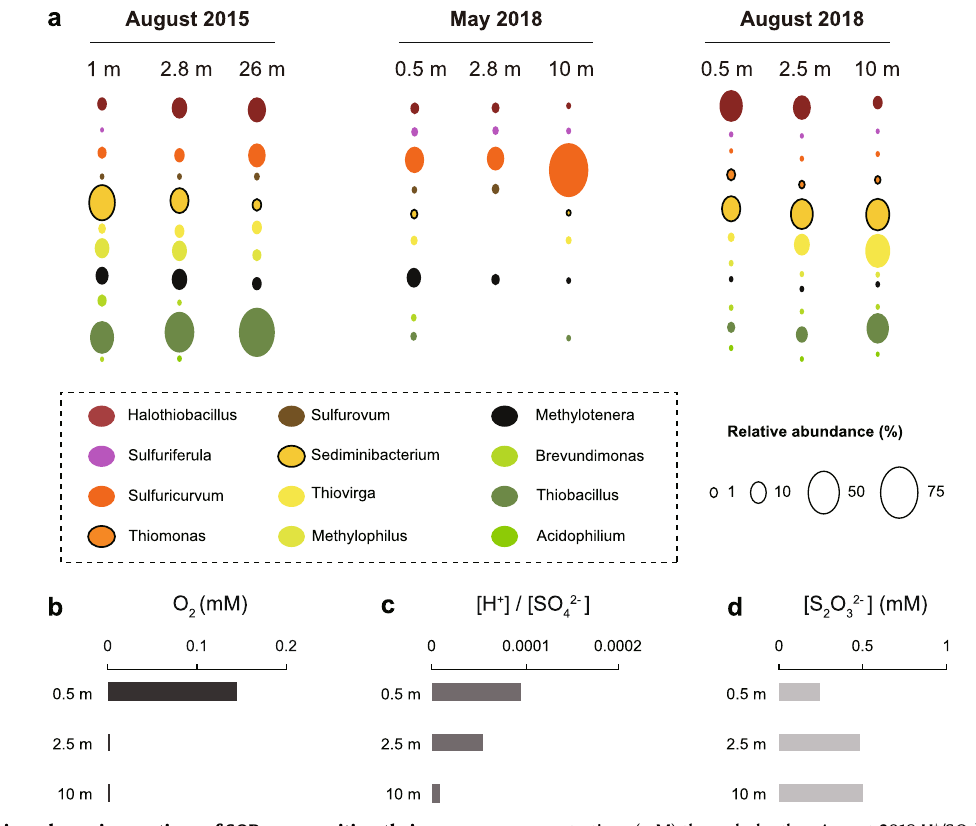
concentrations (mM) through depth. c August 2018 H + /SO 4 2 − ratios throughout depths. d August 2018 thiosulfate concentration (mM) through depth. SOB, sulfur oxidizing